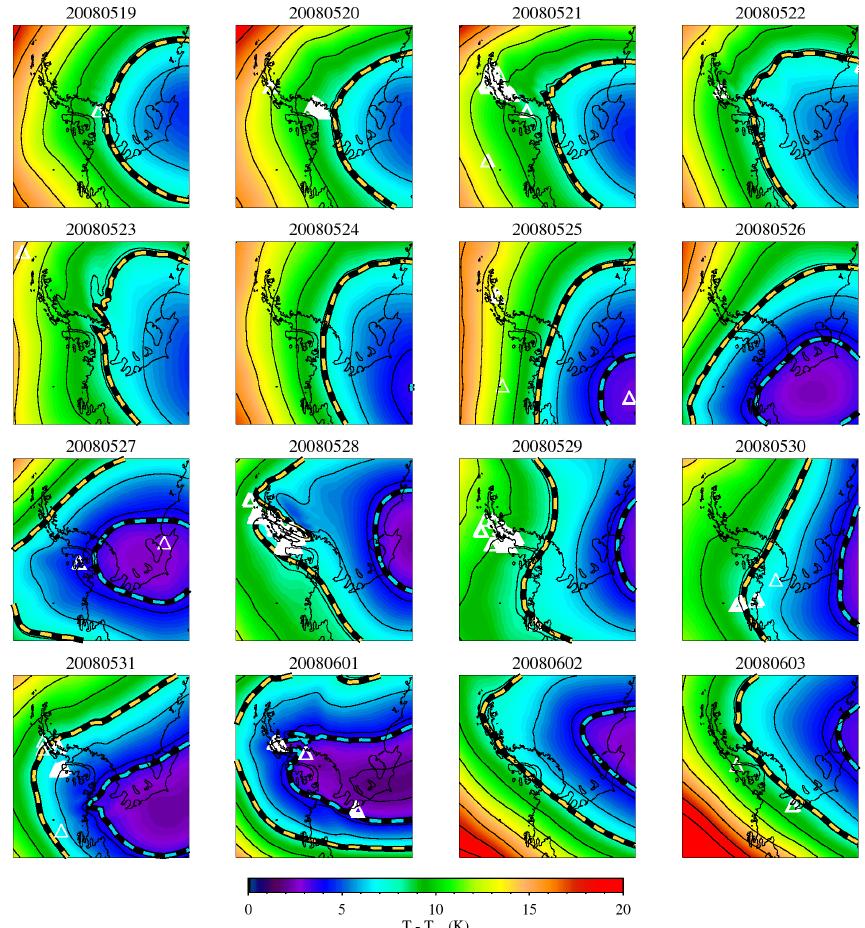
Fig. 10. AIRS detections of gravity waves (white triangles) at 40hPa from 19 May–3 June 2008 over the Antarctic Peninsula region. Colored shading shows the GEOS-5 temperatures relative to the the frost point, T ICE , in Kelvin, with red hues indicating higher temperatures than purple hues (solid black contours are at 2K intervals). Highlighted contours show the existence threshold temperature of NAT (approximately T ICE + 7 . 5K, yellow-black dashed) and formation temperature of STS ( T ICE + 3 . 5K, cyan-black